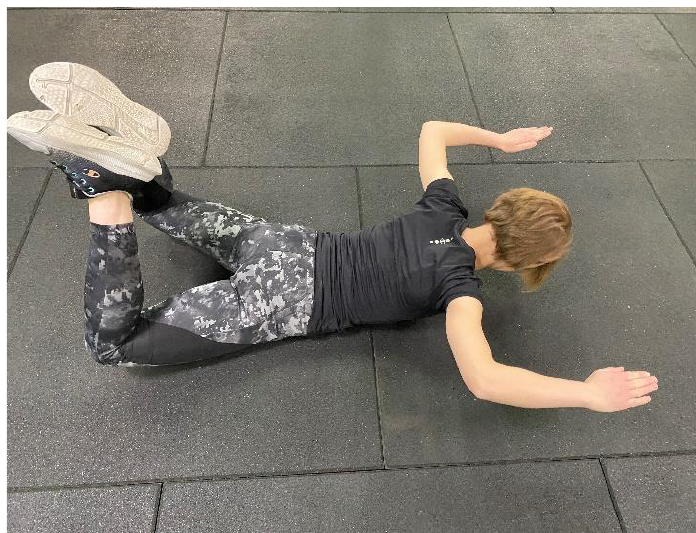
Figure 2. Flying Squirrel Exercise (FSE).